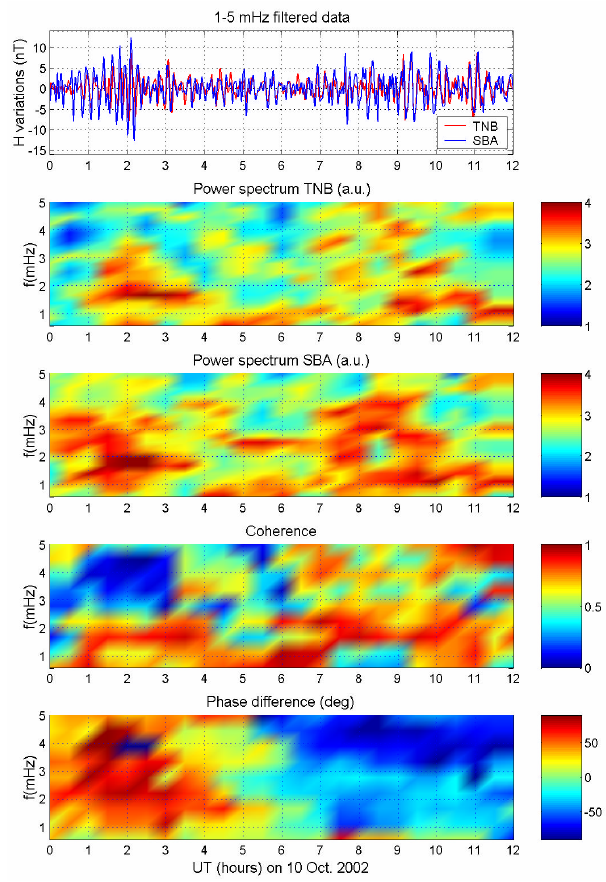
Fig. 8. The same of Fig. 6, for the event occurring between 00:00 and 12:00 UT on 10 October 2002. MLT midnight at SBA and TNB is at 07:00 and 08:00 UT,